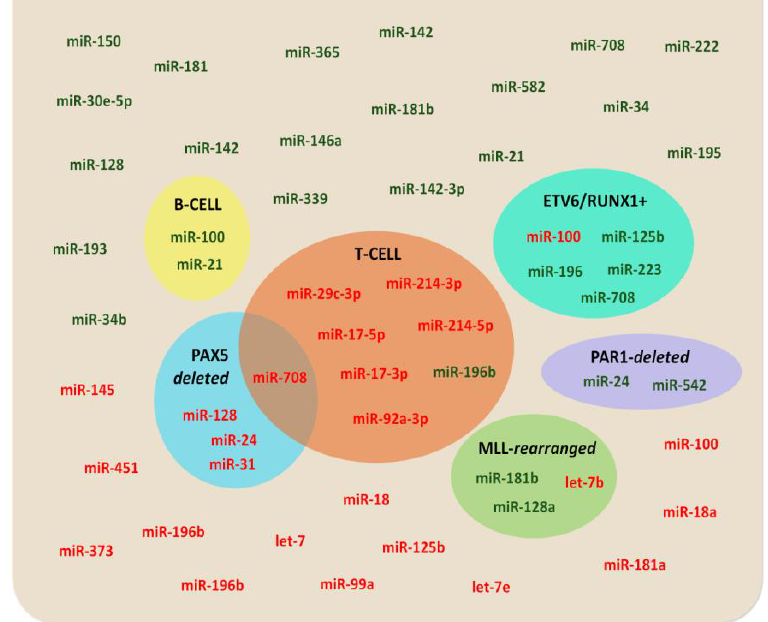
Figure 1. Dysregulated microRNAs (miRNAs) in childhood acute lymphoblastic leukemia. Hyperexpressed and hypoexpressed miRNAs in acute lymphoblastic leukemia within cellular (B-cell or T-cell) or molecular ( ETV6/RUNX1+ , PAX5 -deleted, MLL -rearranged, or PAR1 -deleted) subgroups are denoted in green and red, respectively.